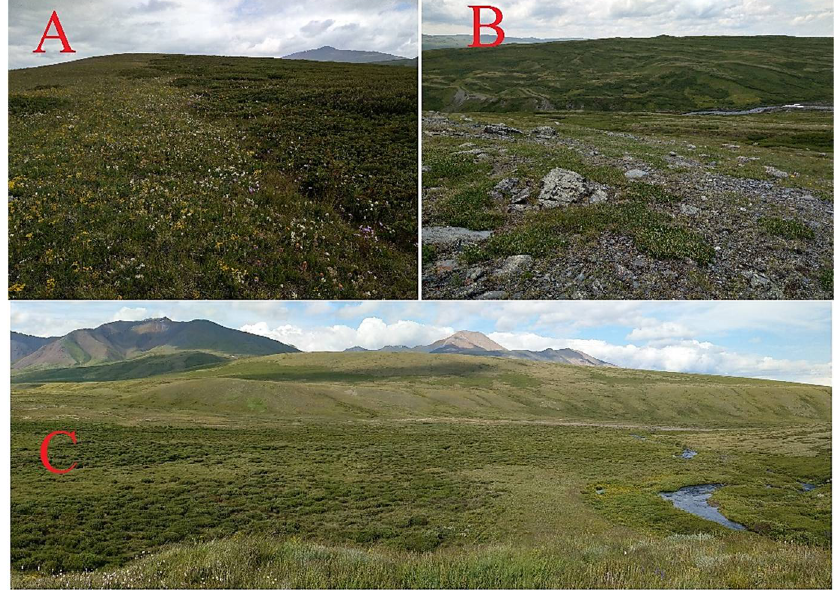
Figure 4. ( A ) Moraine from group A, polygon K1, ( B ) moraine from B2 (polygon K3), and ( C ) general view of the moraines in the Kargy area from the southwest.